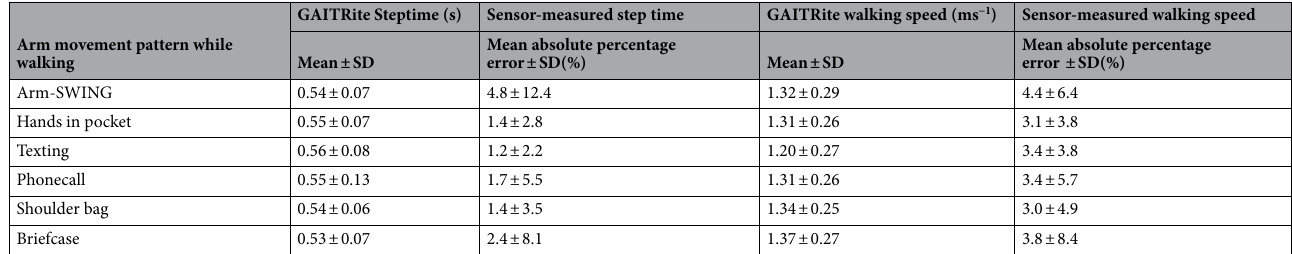
Table 1. Comparison of spatiotemporal gait parameters assessed by the wrist-worn sensors and the electronic walkway (n = 101 with 1487 walks). ms − 1 m per second, s second, SD standard deviation.